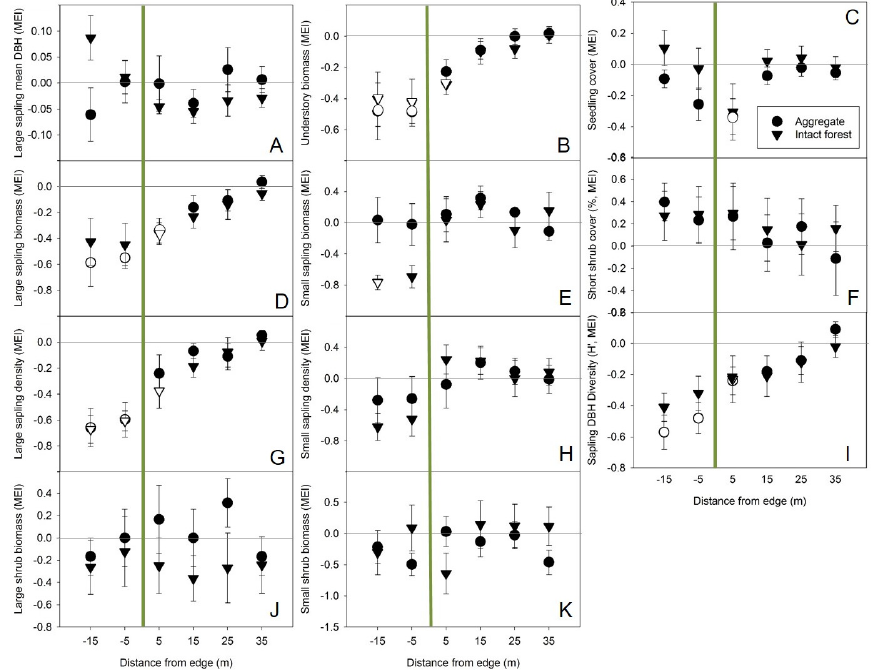
Figure 3. Magnitude of edge influence (MEI) on woody community structure, including all woody stems <10 cm DBH as it relates to the transition between harvested areas and two types of mature forest overstory (aggregates or intact forest, as indicated by symbol shape). Each panel (A ‐ K) presents the MEI for a different structural attribute of regeneration and the woody understory. Observations extend from 15 m within mature canopy ( − 15 m) up to (+) 35 m into clearcuts. Plots at (+) 45 m served as reference conditions. Forest influence is interpreted as occurring where MEI for a particular trait differs significantly from zero ( p < 0.05, indicated by hollow symbols). Solid lines at 0 m (x ‐ axis) indicate the edge between mature canopy (aggregates or intact forest) and adjacent regenerating forest. Total woody biomass (panel D ) includes above ‐ ground stem and branch biomass for all understory woody vegetation >1 m height and with DBH < 10 cm. The legend in panel ( C ) applies to all panels.